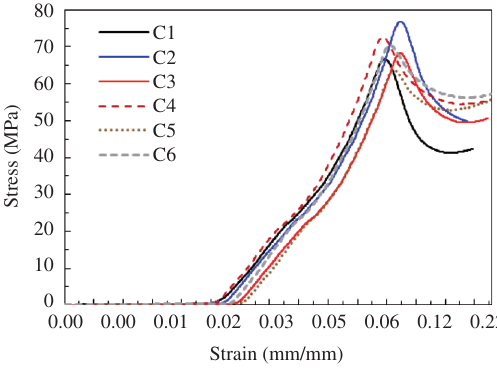
Figure 3 Stress/strain curves of the C1 to C6 composites under compressive loadings.